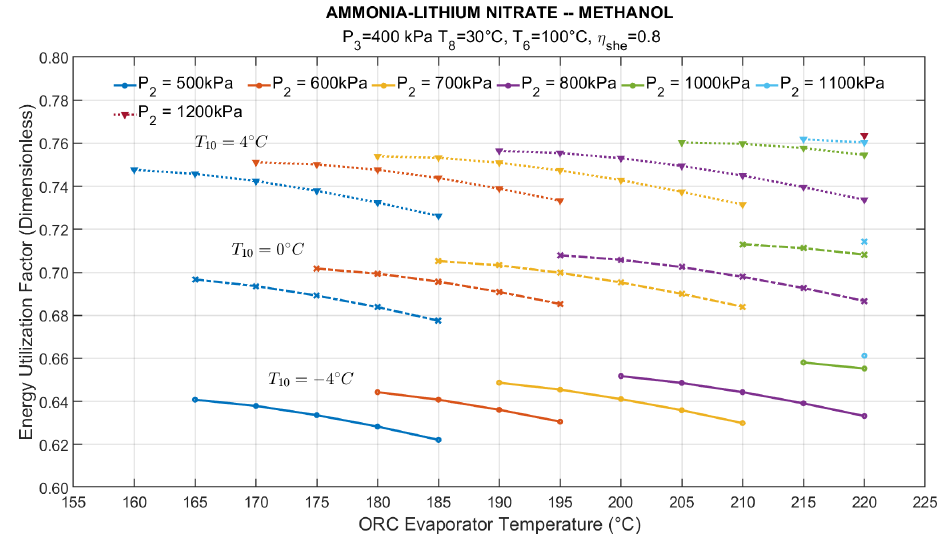
Figure 13. NH 3 -LiNO 3 --CH 3 OH e ff ect of heat source and cooling temperatures on EUF.